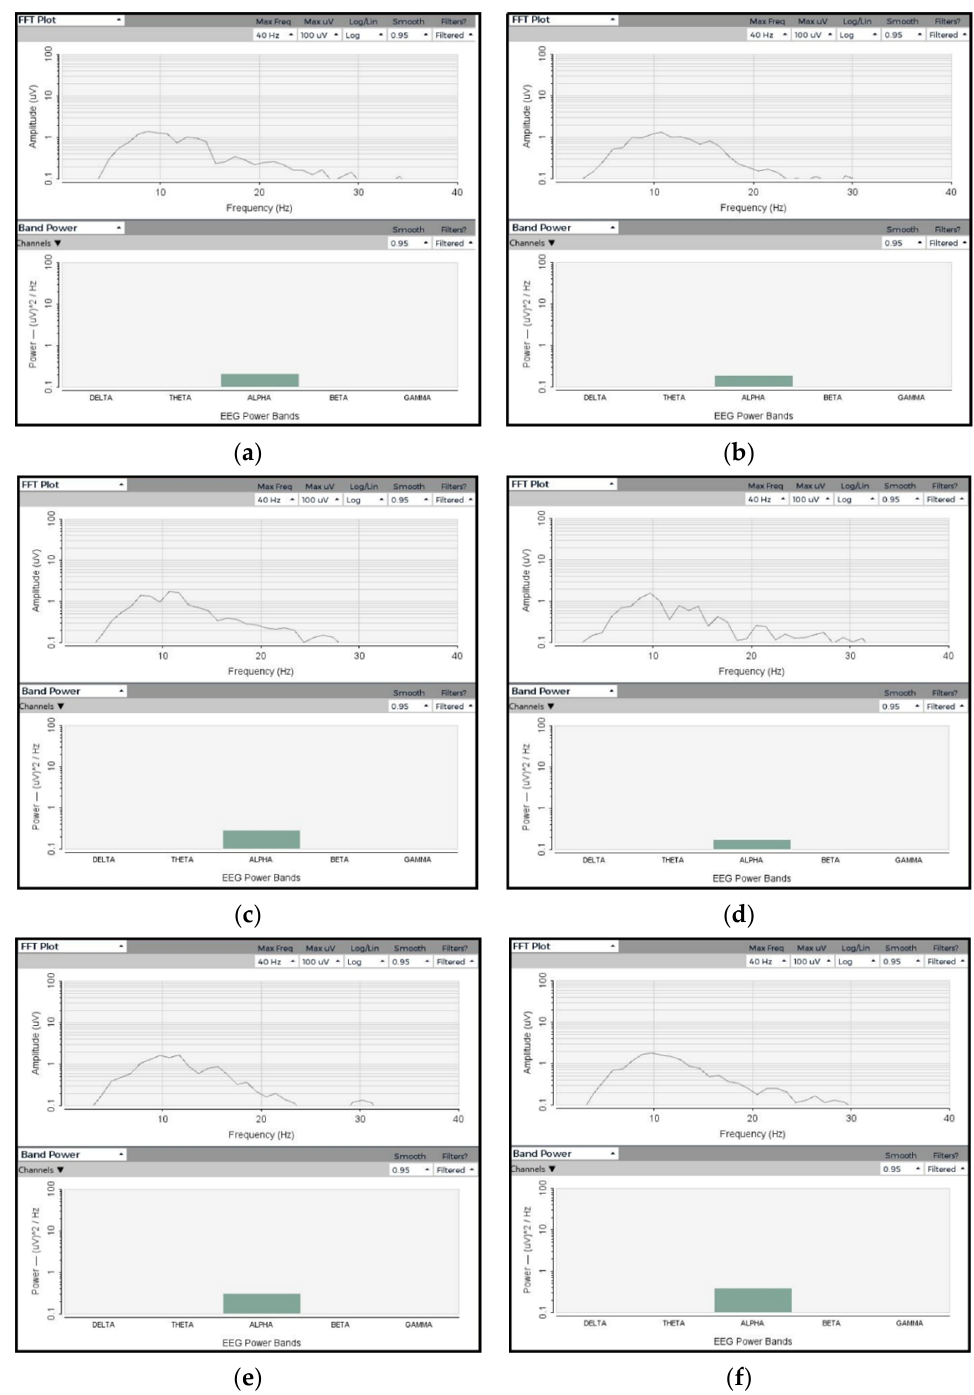
Figure 13. EEG signals from OpenBCI board on textile-based head phantom: ( a ) Ag/AgCl; ( b ) textile electrode 1; ( c ) textile electrode 2; ( d ) textile electrode 3; ( e ) textile electrode 4; and ( f ) textile electrode 5.